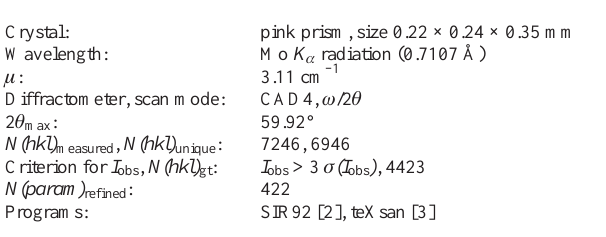
Table 1. Data collection and handling.